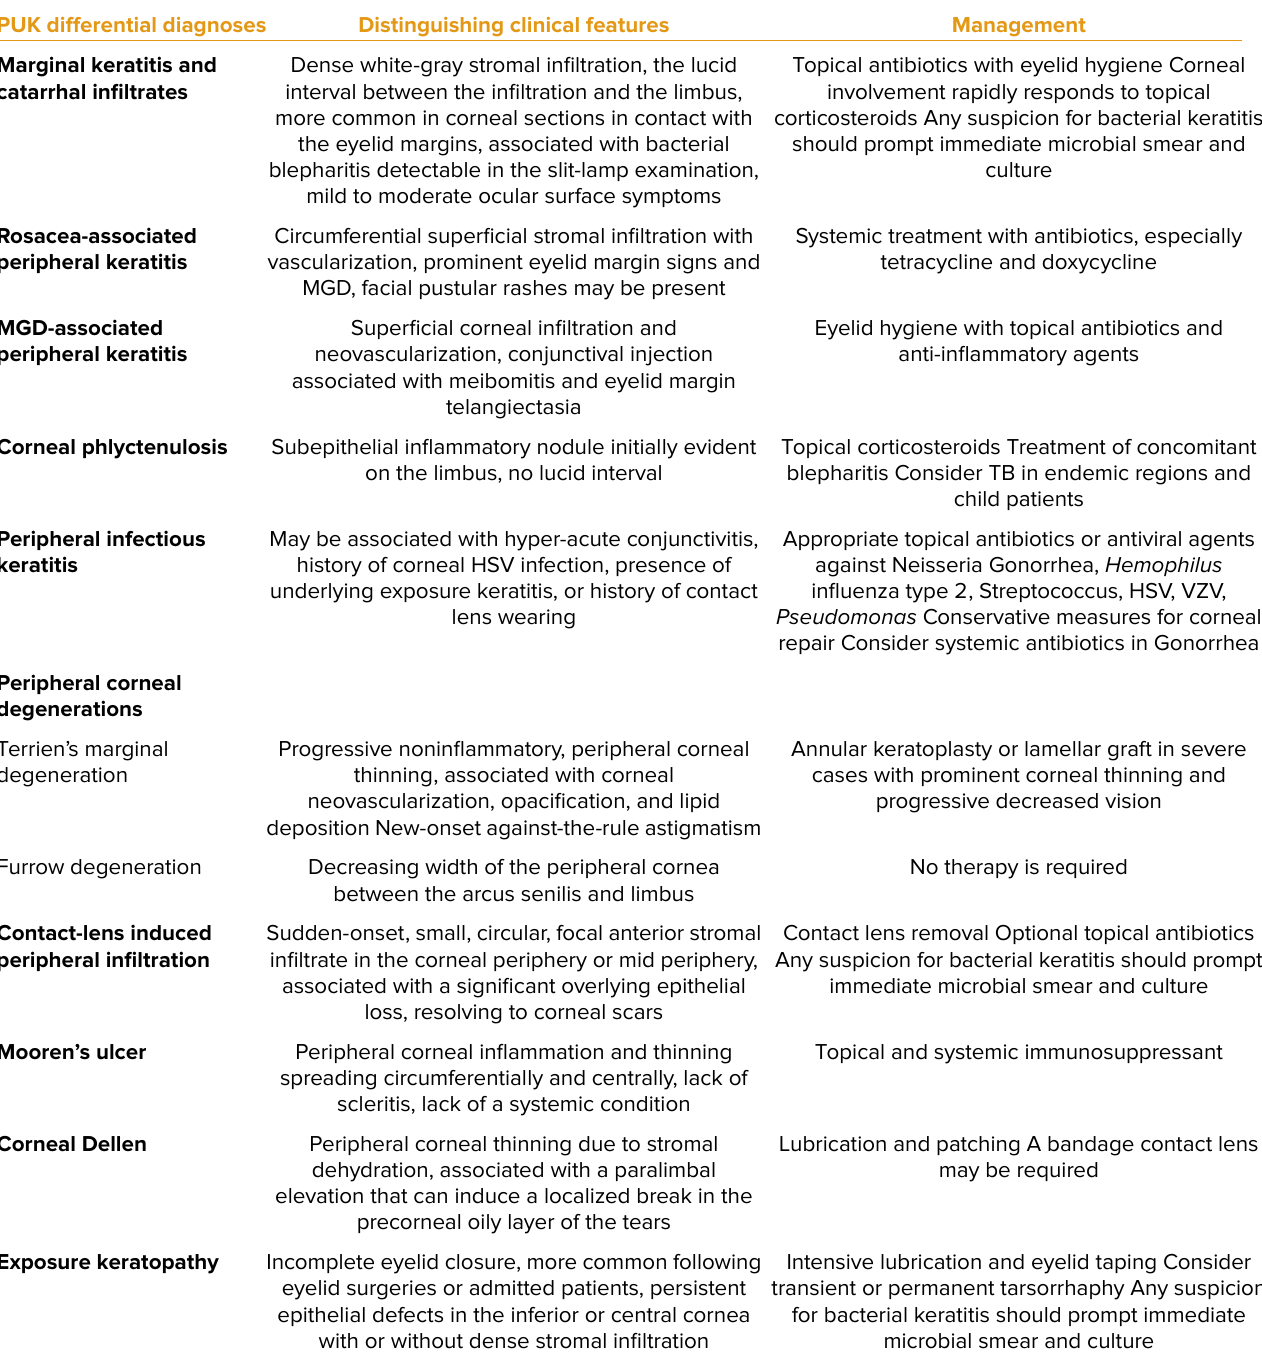
Table 3. Differential diagnoses for PUK PUK differential